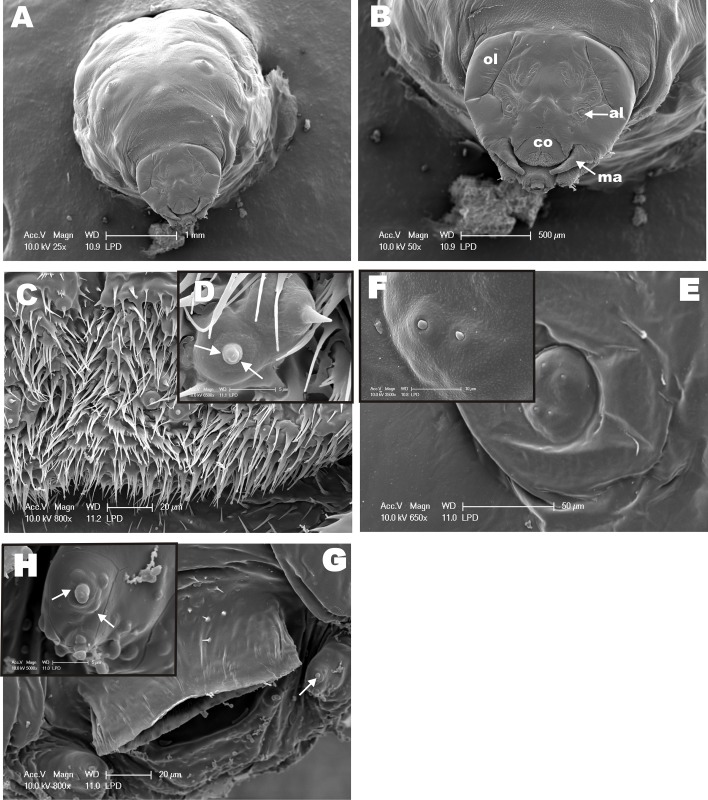
SEM from Pre-Defecating Larva (PDL) of M. scutellaris.(A) Panoramic view of the anterior region, including part of the larvae body. (B) Frontal view of the head showing ocular lobe (ol), antennal lobe (al), clypeus (co), and mandible (ma). (C) Clypeus area showing sensilla-like structures, which are highlighted in (D)—arrows indicate small “black dots” that are orifices at the base of the structure. (E) View of antennal lobe region with four structures similar to immature sensilla, two of which were highlighted (F) in higher magnification. (G) Mandible region also showing structures similar to immature sensilla, which are emphasized in higher magnification in (H) with small orifices indicated by arrows.